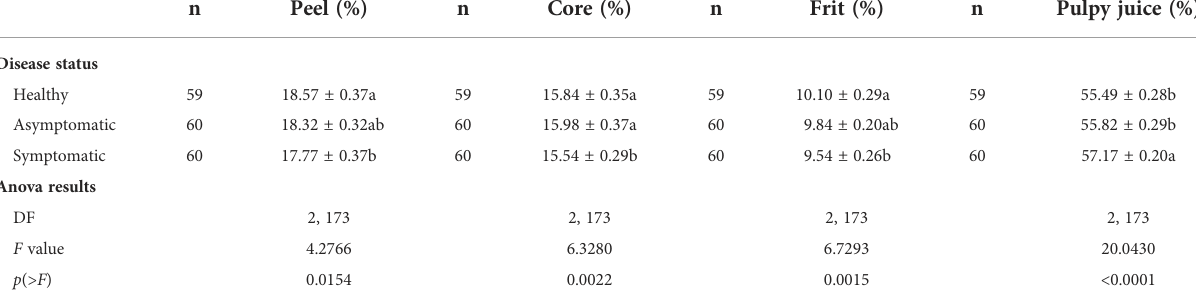
TABLE 3 Mass balance (percentages) of ‘ Femminello ’ lemon fruits from healthy trees and from the asymptomatic and symptomatic sector of HLB-affected trees (diseased trees) collected in the southeastern São Paulo State (average values of fi ve harvest seasons – 2017 to 2021) yz .